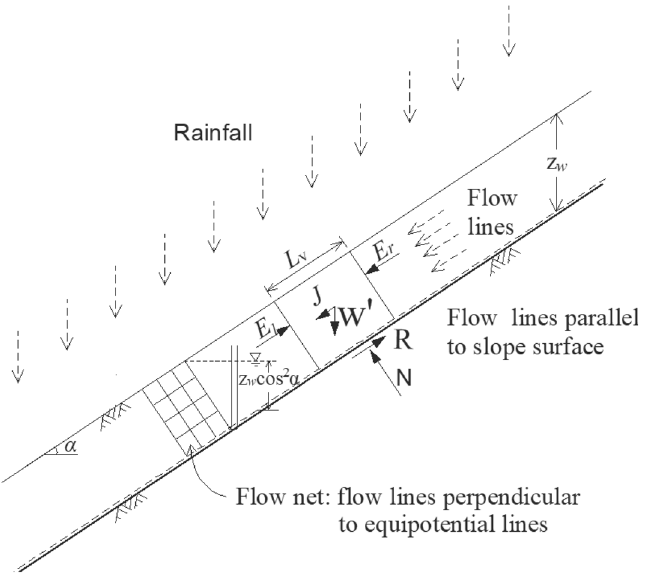
Figure 2. Shallow translational